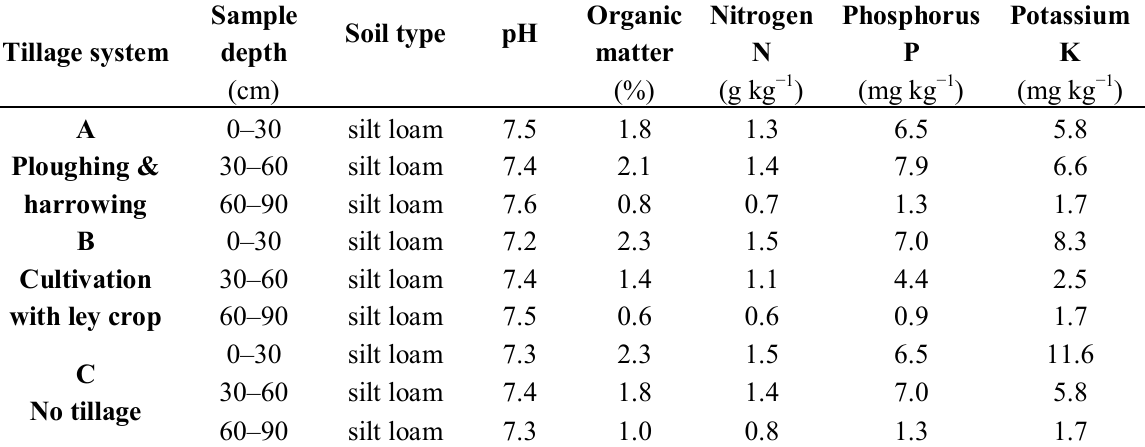
Table 1. Research plot soil types, pH, organic matter and N, P, K